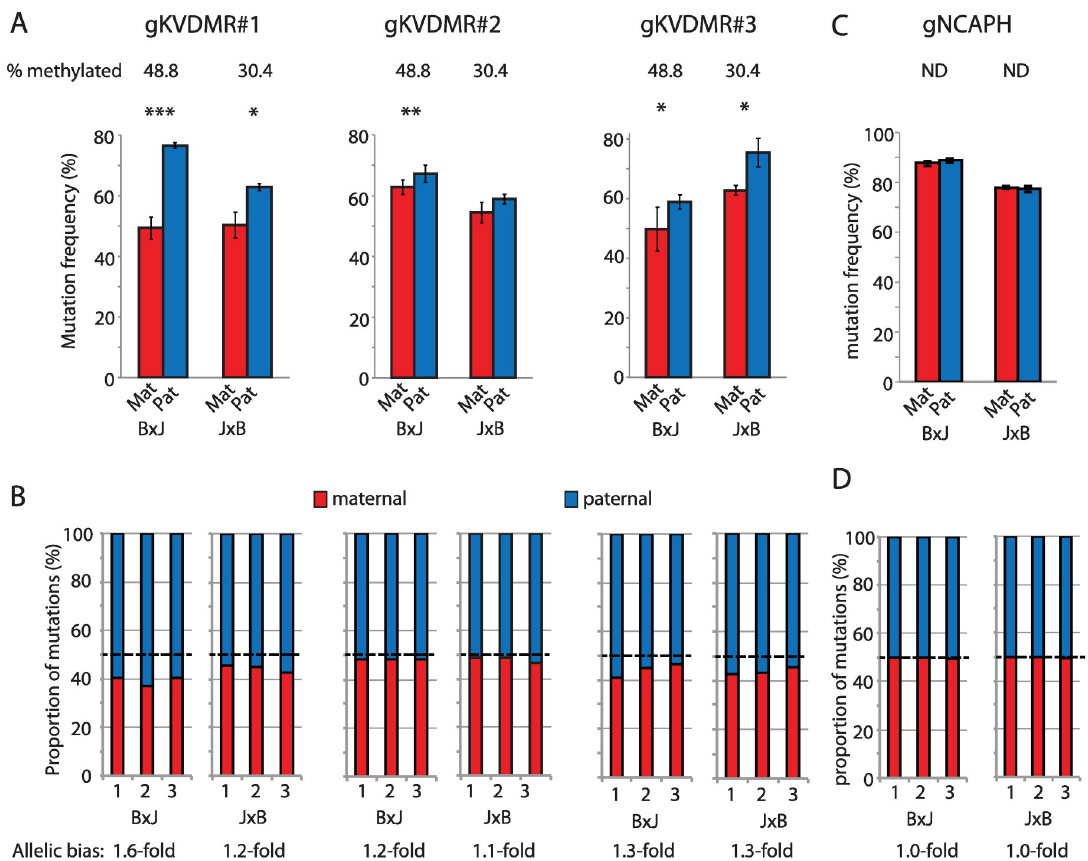
Fig 2. Lower mutation frequency on silenced alleles following 96-hour exposure. (A) Allele-specific mutation frequencies for KvDMR sgRNAs #1–3 in cells harvested 96 hours post transfection, following selection of transfectants in puromycin. Error bars represent SD of three biological replicates; p -values denote two-tailed paired t tests of difference between maternal and paternal alleles. � p < 0.05, �� p < 0.01, ��� p < 0.001. In this, and subsequent figures, the percentage of hypermethylated alleles in mock-transfected cells is shown above the histogram to indicate the degree of imprinting at the time of editing. (B) Stacked histograms show the allelic mutation bias in each experimental replicate. (C, D) Allele-specific mutation frequencies from experiments using an sgRNA (sgNCAPH) targeting a nonimprinted locus, presented as described in panels A and B. Quantitative data underlying all panels are provided in S1 Data, and details of MiSeq libraries including SRA accessions are provided in S2 Data. Mat, maternal; ND, methylation analysis not done; Pat, paternal; sgRNA, single guide RNA; SRA, Sequence Read